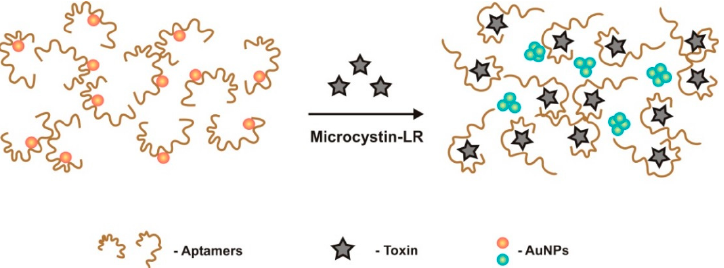
Figure 7. Highly sensitive colorimetric aptasensor for detection of microcystin-LR (MC-LR) [49]. Gold nanoparticles (AuNPs) plasma resonance absorption red peak shifts upon binding of the target. Since the random coil aptamer adsorbed on AuNPs change into the regulated structure, forming MC-LR-aptamer complexes, which cause the release AuNPs from the surface of aptamers, leading to their aggregation, and the color shift from red to